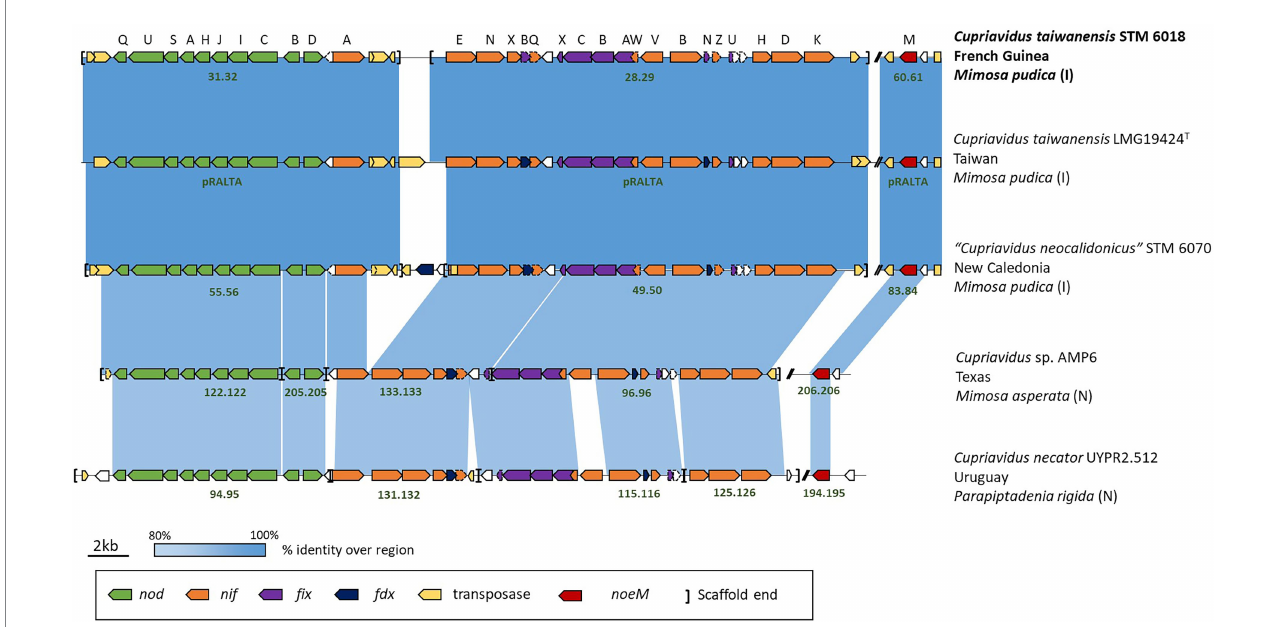
FIGURE 1 Schematic of the gene neighborhoods of symbiotic Cupriavidus species, showing nodulation ( nod ), nitrogen fixation ( nif, fdx and fix ) and transposase gene cluster alignments. Information on the microsymbiont’s host species, geographical location, and whether the host is introduced (I) or native (N) to the location is included. The scaffold number or replicon name is in dark green text and two bars (//) represent gaps in the sequence between the genes of interest.